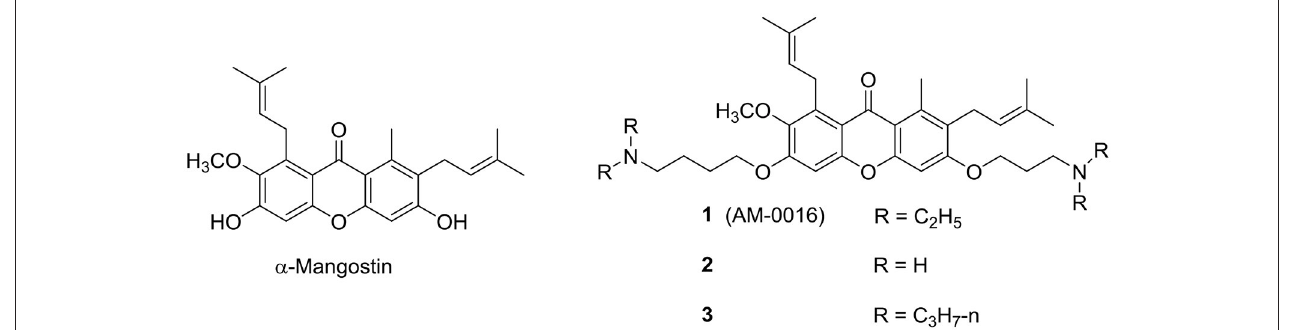
FIGURE 3 | α -Mangostin-derived xanthones with antimycobacterial activity.